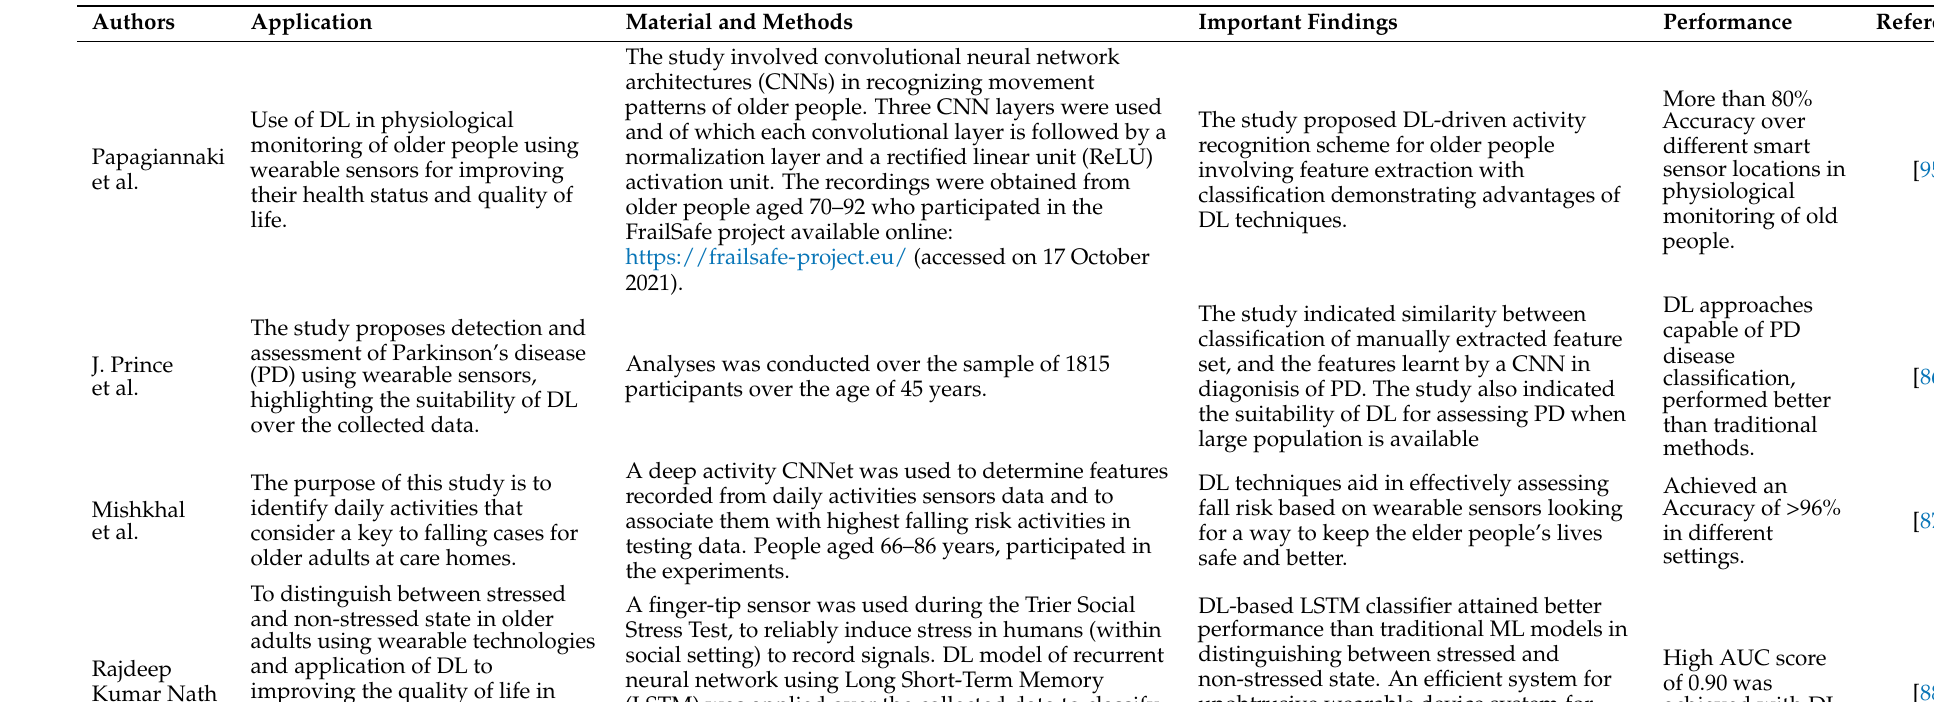
Table A6. Application of DL in predicting other aging-related issues using sensor-based